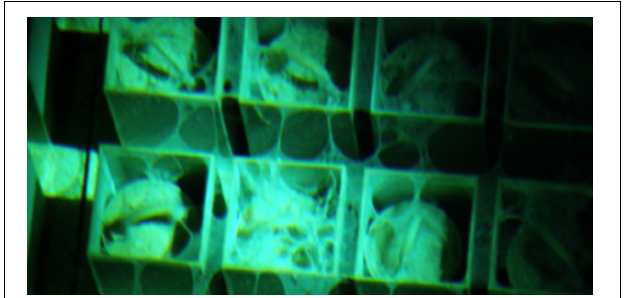
FIGURE 1 | Underwater view of spent nuclear fuel canisters supported in a storage rack. Anomalous flocculent can be seen spanning the tops of individual fuel canisters and spreading between them along the storage